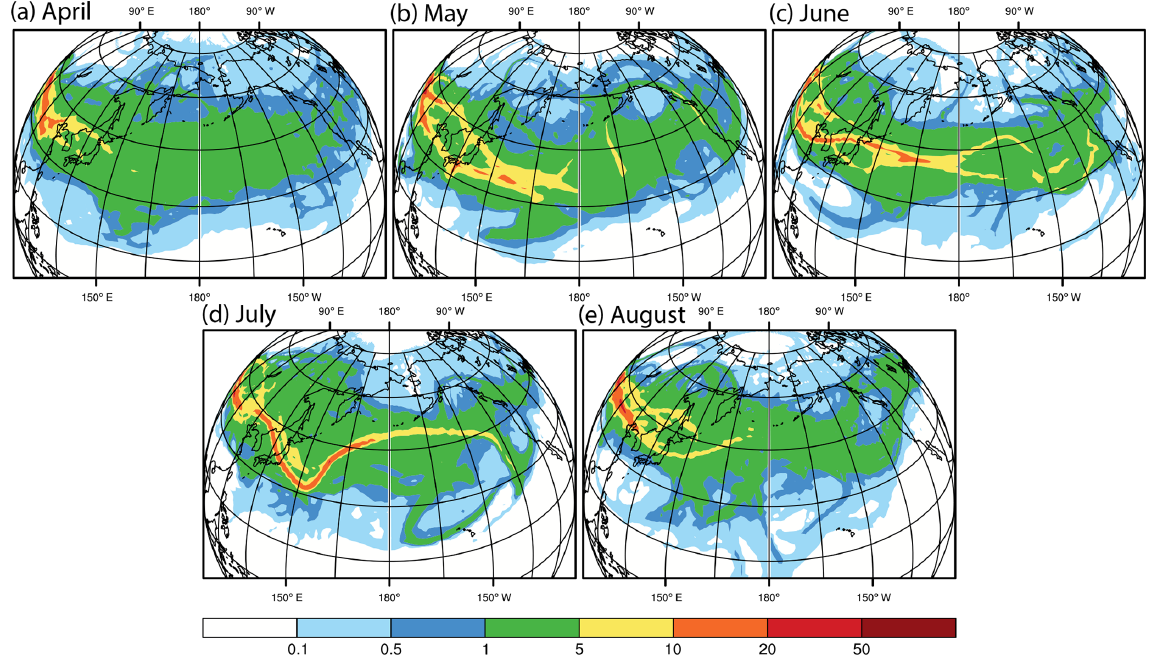
Figure 8. Trajectory passage frequency (% of trajectories) from the Taklamakan Desert in (a) April, (b) May, (c) June, (d) July, and (e) August during 2001–2011. These months are analyzed because there are at least 10000 data points with initial injection height exceeding 2kma.m.s.l. in each of these months. The trajectory passage frequency is calculated as the number of trajectories crossing over each 1 ◦ latitude × 1 ◦ longitude grid in the Northern Hemisphere divided by the total number of trajectories from the Taklamakan Desert in each